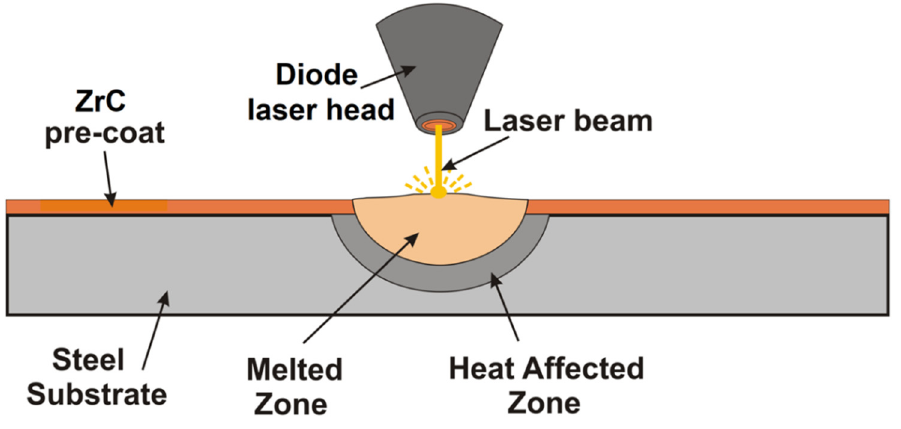
Figure 2. Schematic of Fe/ZrC coating production using laser